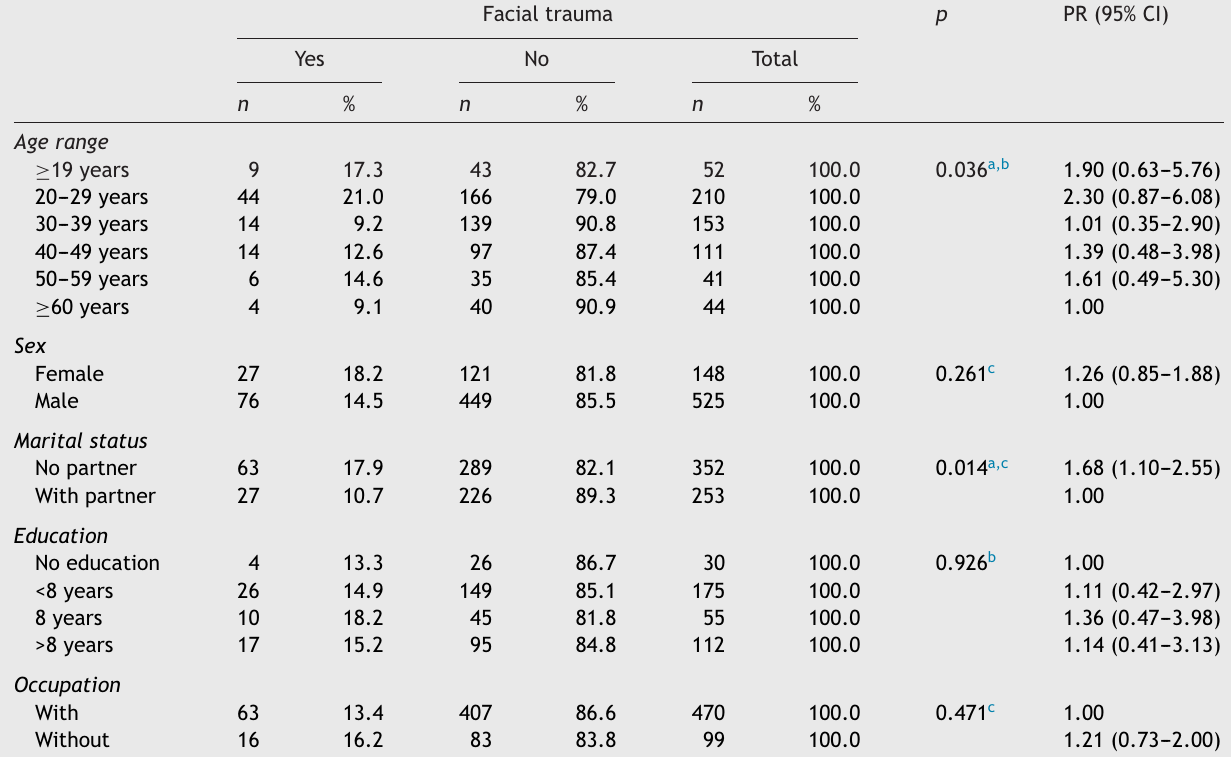
Bivariate analysis of the occurrence of facial trauma and socio-demographic characteristics of victims of terrestrial transport